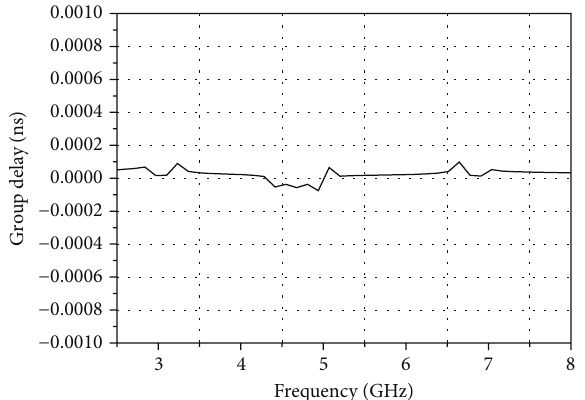
Figure 11: Group delay for the proposed CPW-fed two-sided T strip wideband microstrip